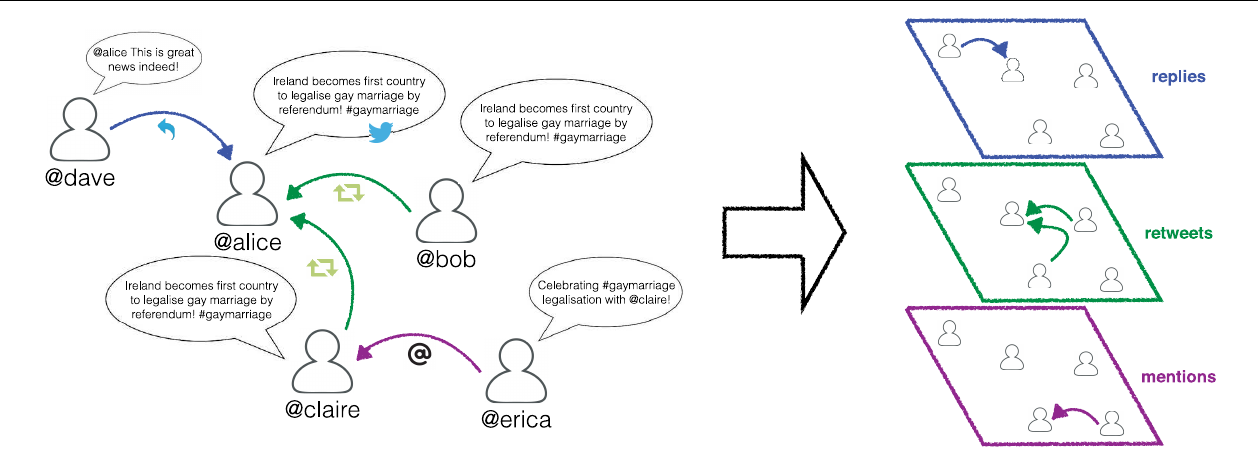
FIGURE 1 | Illustrative example of a multilayer network representing the different interactions between Twitter users in the context of an exceptional event. Different colors are assigned to different actions.